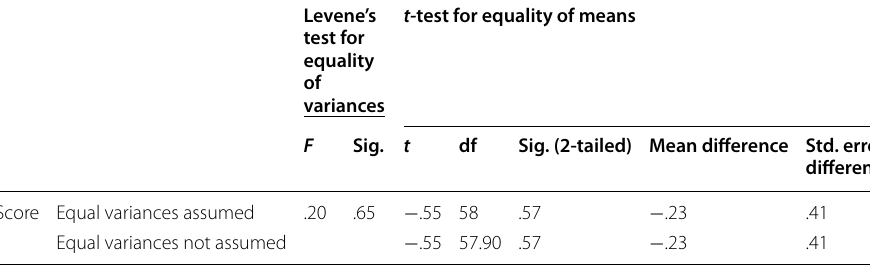
Table 12 Inferential statistics (complexity pre‑test of both groups)